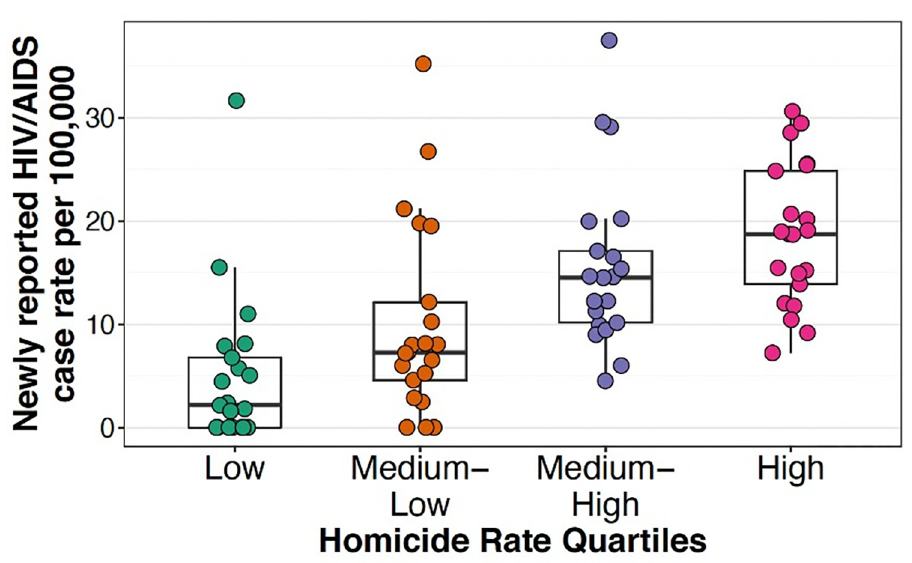
Fig 3. Newly reported HIV/AIDS case rate for women per 100,000 according to homicide rate quartiles (p for trend = 0.049).